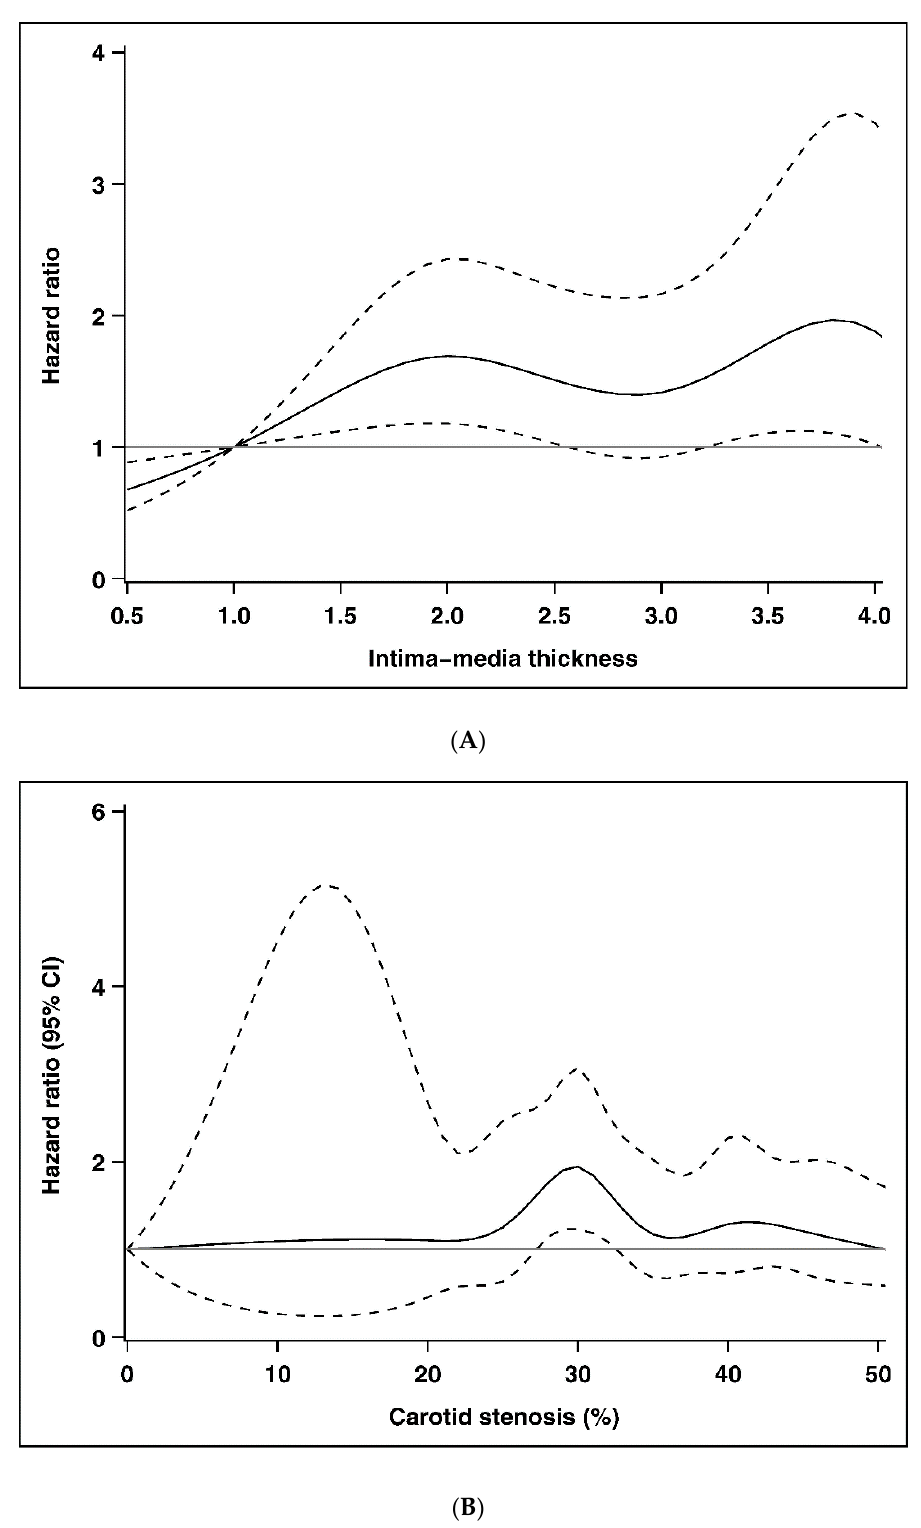
Figure 2. Multivariable restricted cubic spline plots for all-cause mortality by ( A ) intima–media thickness and ( B ) carotid stenosis.